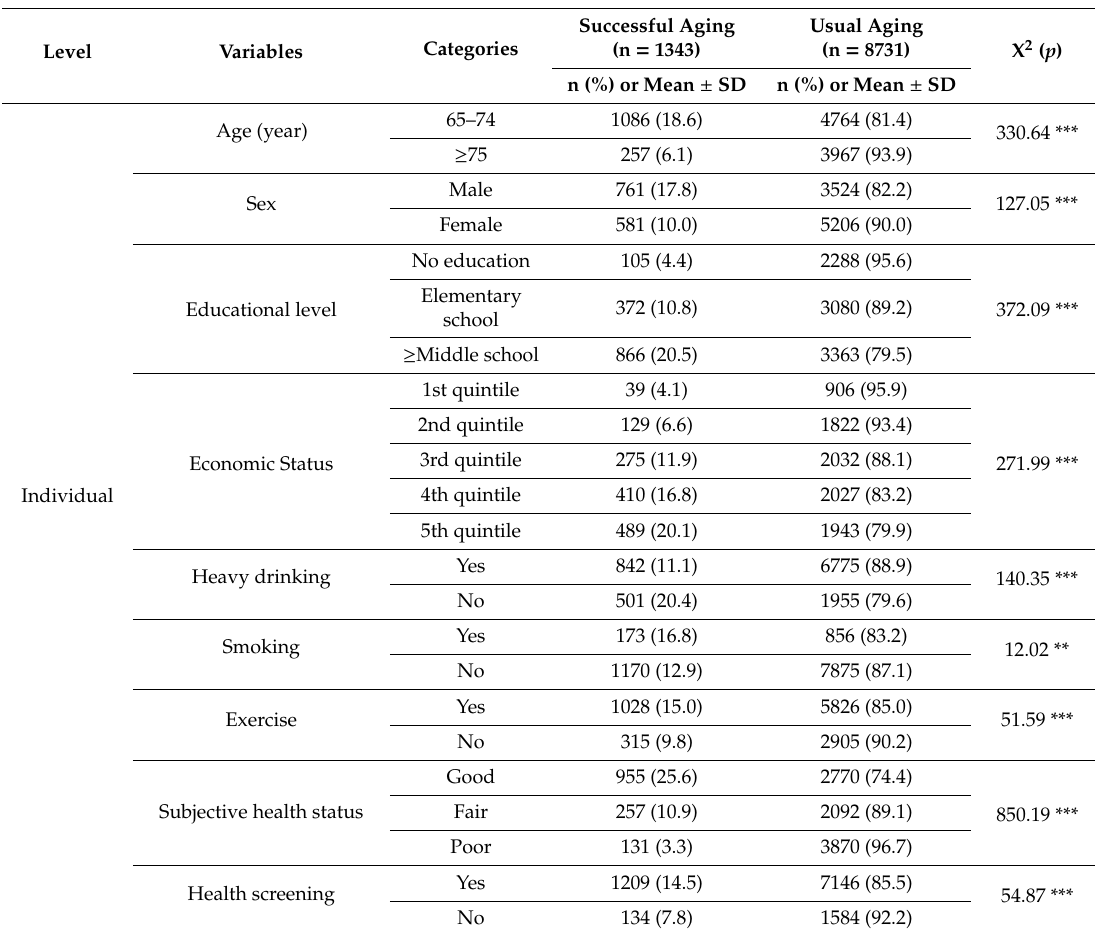
Table 2. The Di ff erences in Successful Aging According to the Individual, Family, and Community System-related Variables. N =